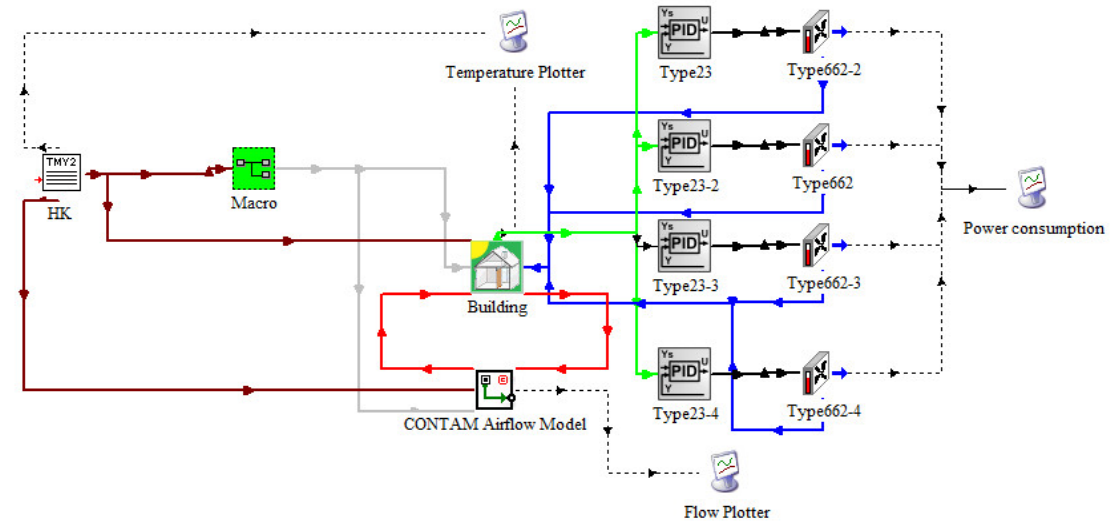
Figure 11. TRNSYS-CONTAM joint control platform.